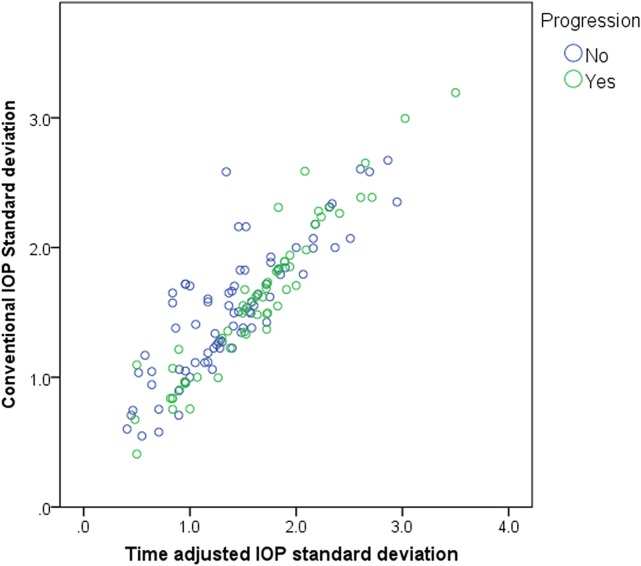
Relationship between conventional and time adjusted intraocular pressure (IOP) standard deviations (SDs).The two variables were significantly related to each other, but deviation from direct proportion is more common in non-progression group. The ratio between conventional IOP SD and time adjusted IOP SD was significantly smaller in progression group than non-progression group (P = 0.002).